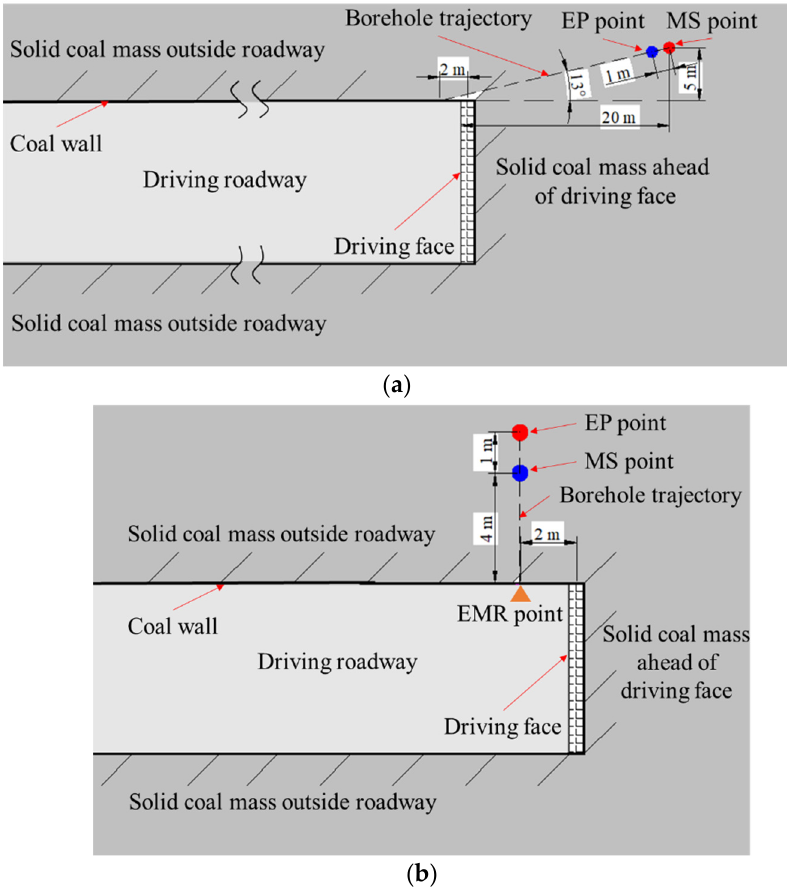
Figure 2. Planar diagram of EP measuring points around the driving face. ( a ) Ahead of the driving face; ( b ) Behind the driving